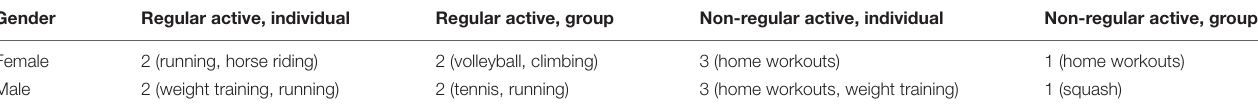
TABLE 1 | Description of study